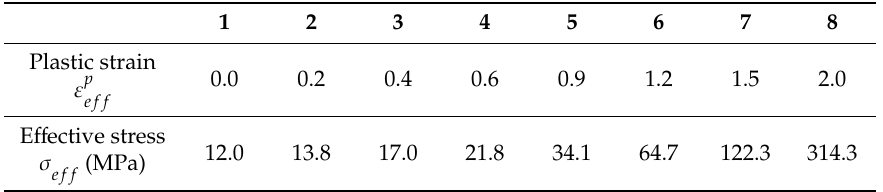
Table 4. Material constants of the applied constitutive model of the PLGA bioresorbable